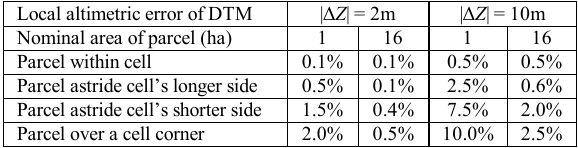
Table 8. Relative errors in area measurement on orthoimagery: contribution of the perspective lever effect for ( D / H ) max = 1/3 Of course, besides positional errors in the image, other quantifiable factors affect the performance of area